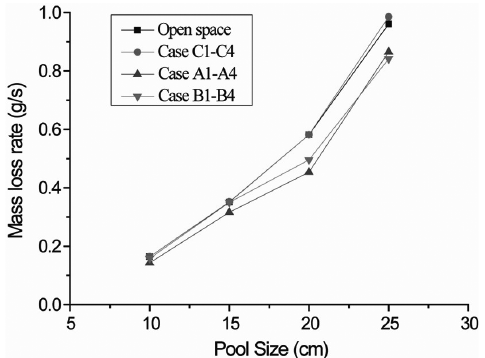
Fig. 12. Mass loss rate of different cases in steady stage (Case 2 A1-A4: top vent open, door 3 size: 0.12 m ; Case B1-B4: top 2 vent open, door 3 size: 0.24 m ; Case C1-C4: top vent close, 2 door 3 size: 0.24 m